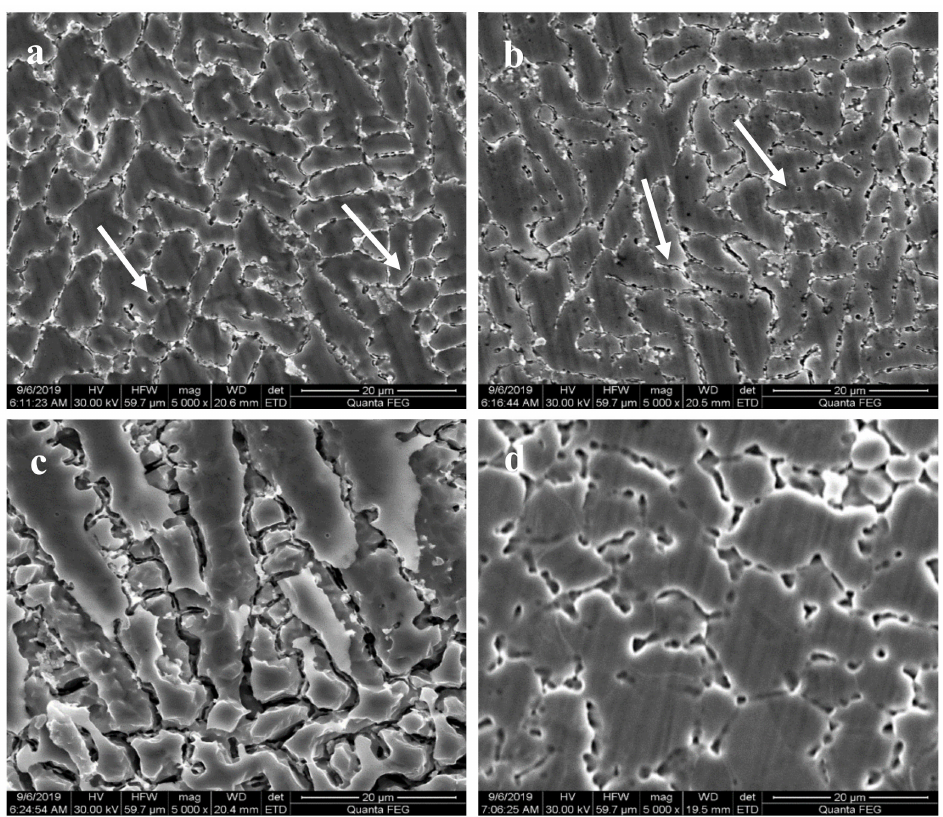
Figure 7. Surface morphologies of ( a – c ) the C22 coating corroded at 50–70 ◦ C and ( d ) C22 bulk corroded at 70 ◦ C: ( a ) 50 ◦ C, ( b ) 60 ◦ C, and ( c ) 70 ◦